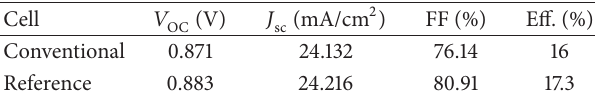
Table 3: Comparison of both